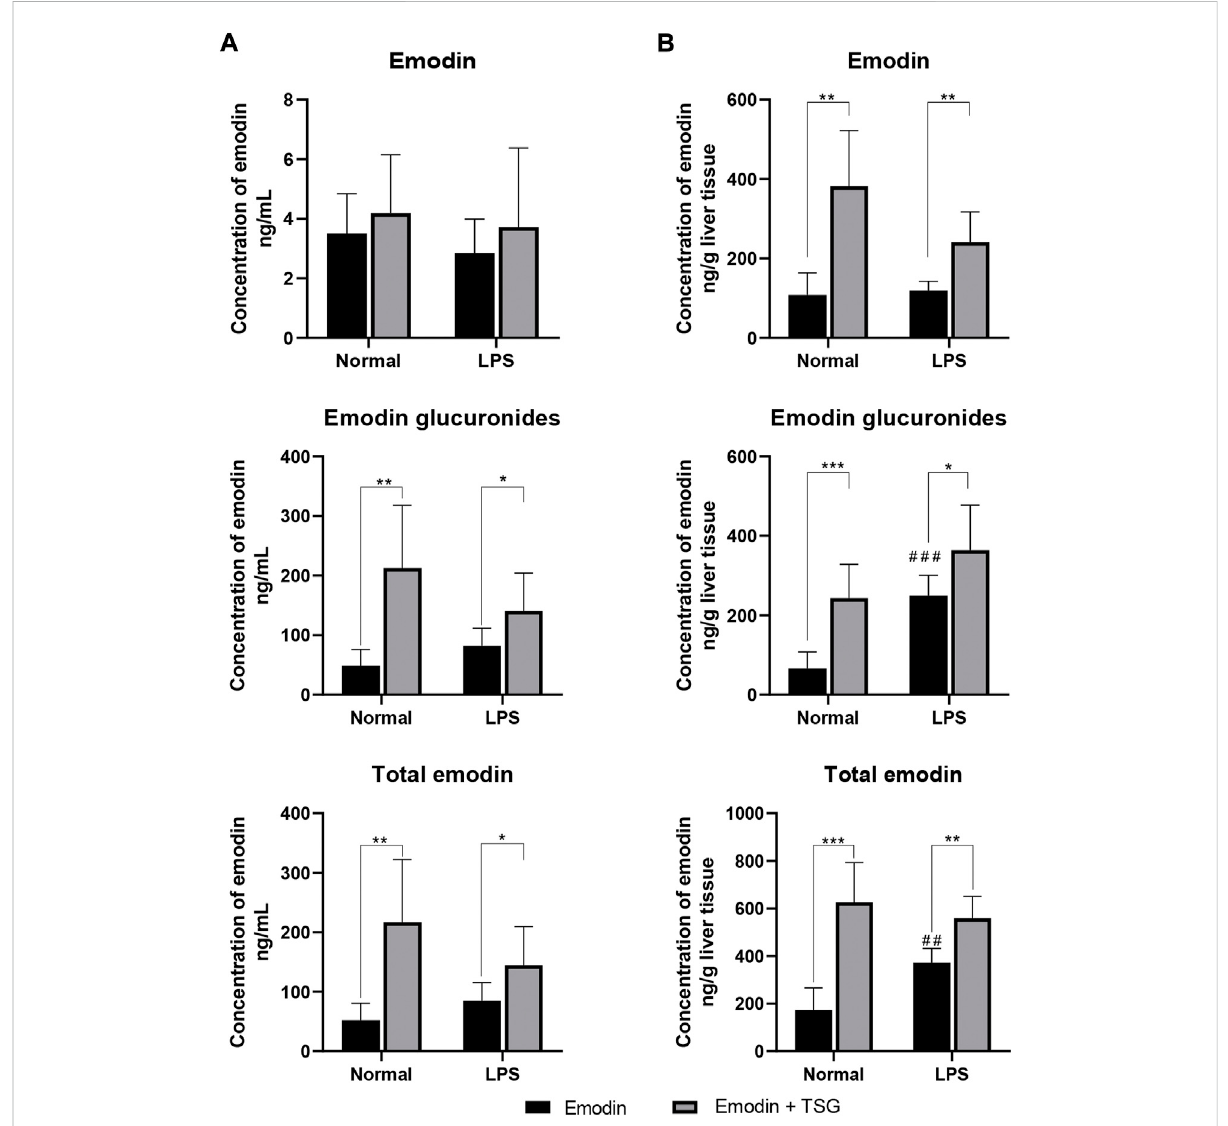
FIGURE 1 Concentrations of emodin, emodin glucuronides, and total emodin (emodin + emodin glucuronides) in plasma (A) and liver (B) after treatment with emodin or its combination with TSG in the normal or LPS-mediated in fl ammatory stress model rats. The data are expressed as the mean ± SD ( n = 6). * p < 0.05, ** p < 0.01, *** p < 0.001 by Student ’ s t-test compared between the Emodin and Emodin + TSG groups, ## p < 0.01, ### p < 0.001 by Student ’ s t-test compared with Emodin group in normal